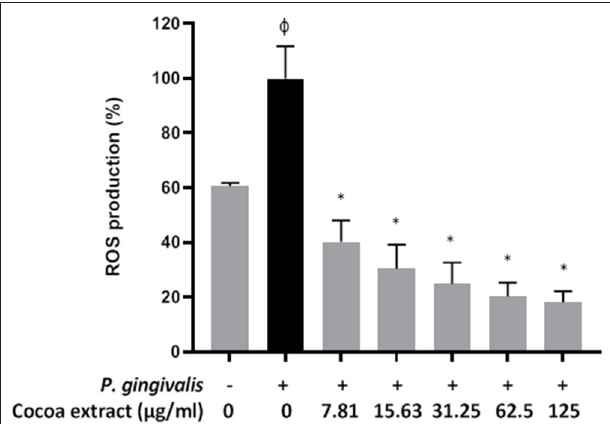
FIGURE 8 | Effect of the cocoa extract on P. gingivalis -induced ROS production by oral keratinocytes. Bacteria were used at MOI of 10 3 , and ROS production was monitored by recording the fluorescence at excitation and emission wavelengths of 485 and 528nm, respectively, following a 6-h incubation (37 ◦ C/5% CO 2 ). A relative value of 100% was assigned to ROS production in the absence of the cocoa extract. ϕ , significant increase compared to the control (no P. gingivalis stimulation). *significant inhibition ( p < 0.001) compared to the control (no cocoa extract + P. gingivalis stimulation).